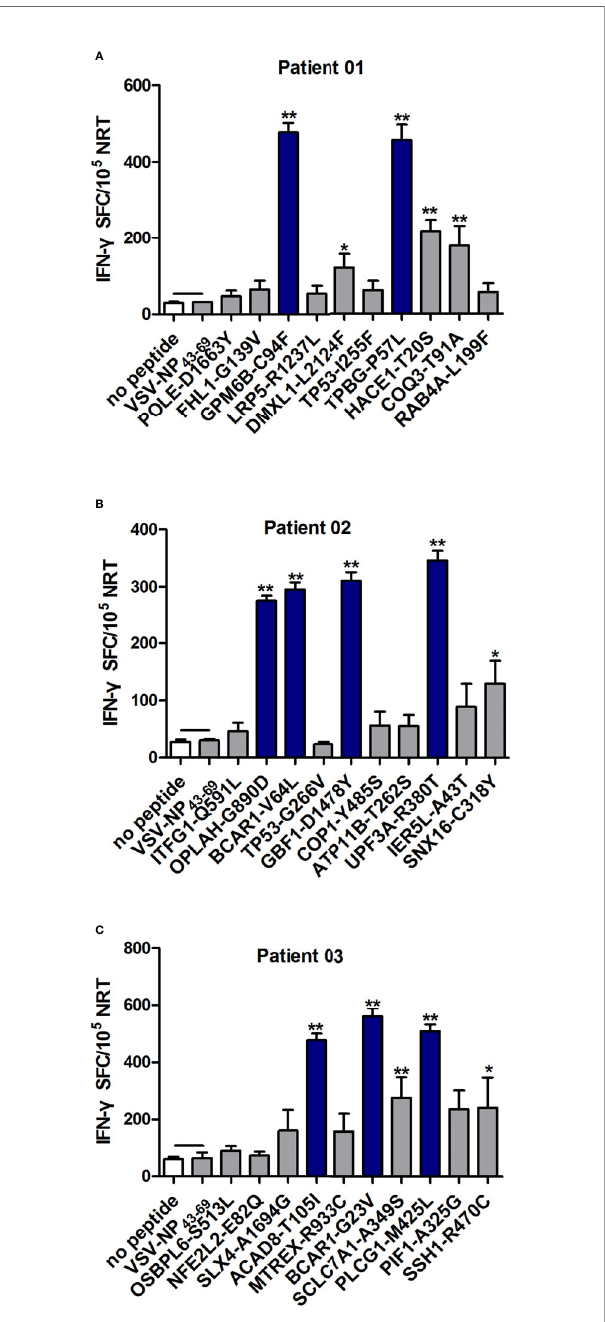
FIGURE 2 | Evaluation of the immunogenicity of neoantigens from patients with NSCLC. Autologous PBMCs were stimulated with candidate mutated peptides every 3 days in the presence of IL-2, and on day 10, the T cell responses to each antigen were measured by IFN- g ELISPOT assay. The PBMCs in A – C were obtained from NSCLC patients 01, 02, and 03, respectively. Stimulation with the no-peptide control (medium only) or irrelevant peptide VSV-NP 43-69 (STKVALNDLRAYVYQGIKSGNPSILHI) was performed as controls. The data are presented as the means ± s.e.m.s from three independent experiments. ** P <0.01 and * P <0.05 were obtained for the comparison of IFN- g production by PBMCs stimulated without a peptide or with irrelevant peptide VSV-NP 43-69 . SFC, spot-forming cell; VSV-NP, vesicular stomatitis virus expressing in fl uenza